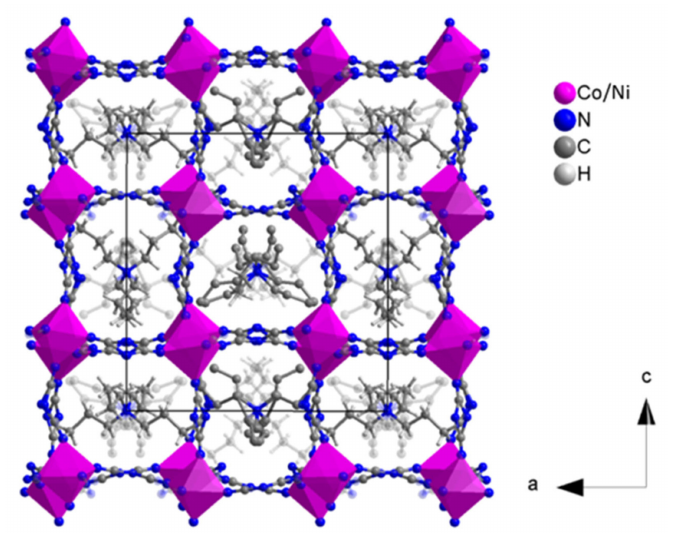
Figure 4. A polyhedral/ball-and-stick representation of the crystal structure of [TPrA][Co 0.5 Ni 0.5 (dca) 3 ] polymorph I (T = 100 K) along the b